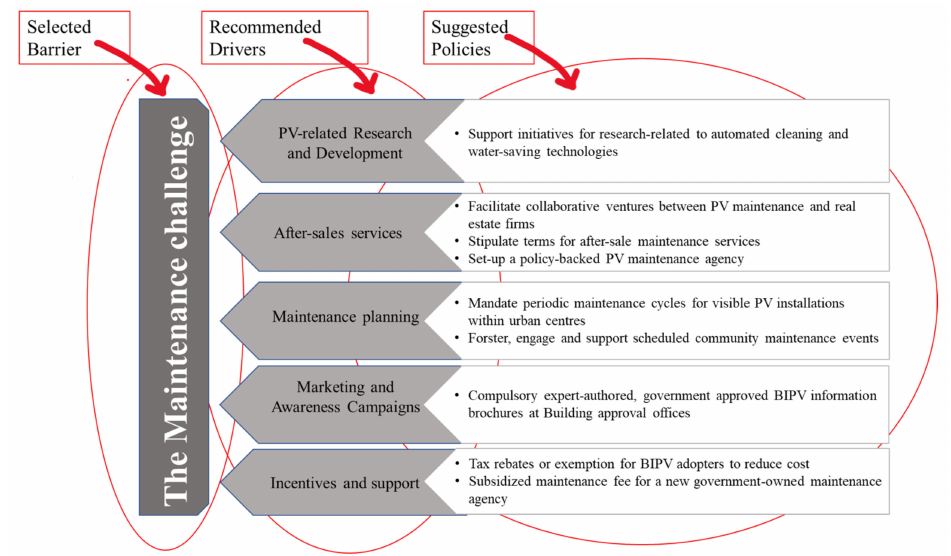
Figure 9. Resolving the maintenance challenge barrier using recommended drivers and sug- gested